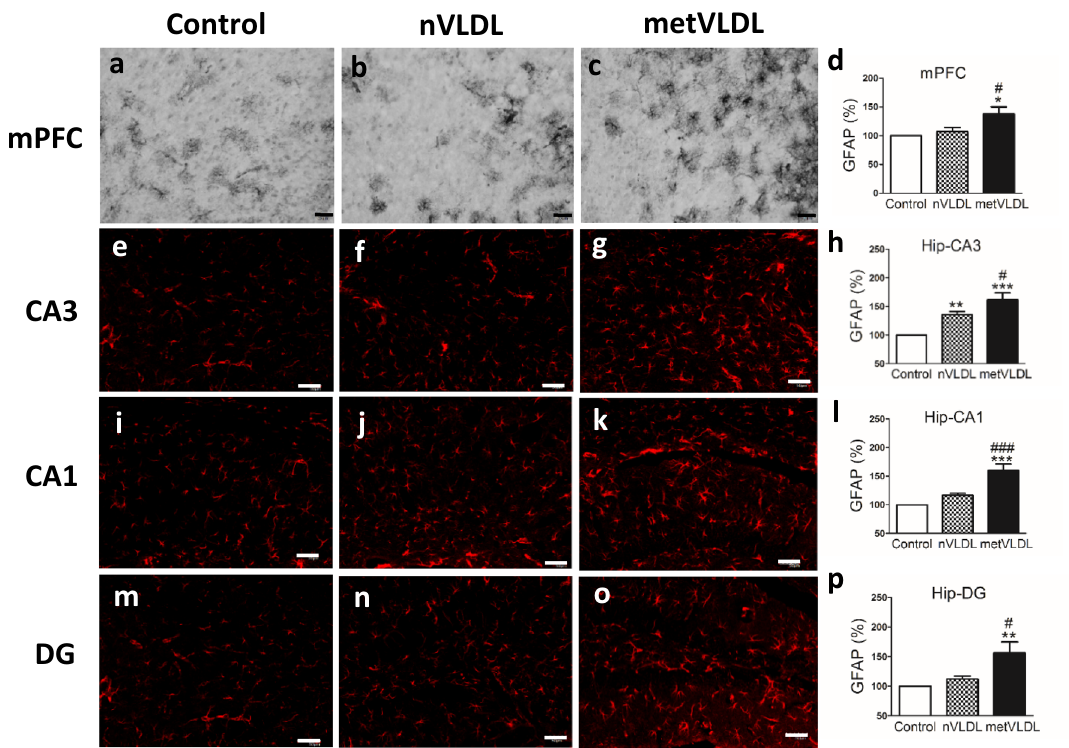
Figure 4. Immunostaining showing the expression of GFAP (astrocytes) in the medial prefrontal cortex (mPFC) and hippocampus CA3, CA1, and dentate gyrus (DG) of mice after 6 weeks of injections with saline (control: a , e , i , m ), 15 μg/g nVLDL ( b , f , j , n ), or 15 μg/g metVLDL ( c , g , k , o ). Magnification = 20X; scale bar = 50 μm. The percentage of GFAP immunostaining (%) in mPFC ( d ), CA3 ( h ), CA1 ( l ) and DG ( p ), calculated by using cellSens Dimension software (version 1.13, Olympus), is compared among groups (n ≥ 7 in each group). Data are shown as the mean ± standard error of the mean. *p < 0.05, **p < 0.01, ***p < 0.001 vs. control. #p < 0.05, ###p < 0.001, nVLDL vs. metVLDL groups. P-values were determined by using one-way analysis of variance with the Newman-Keuls post-hoc test.